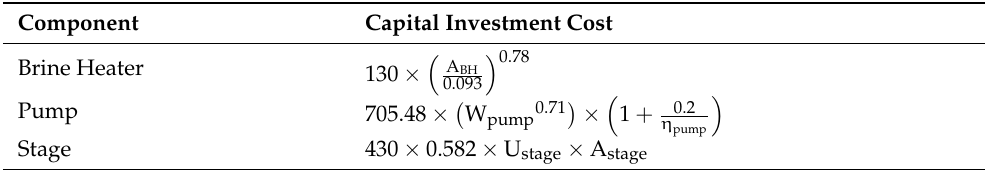
Table 4. Capital investment cost (Z k ) for desalination system